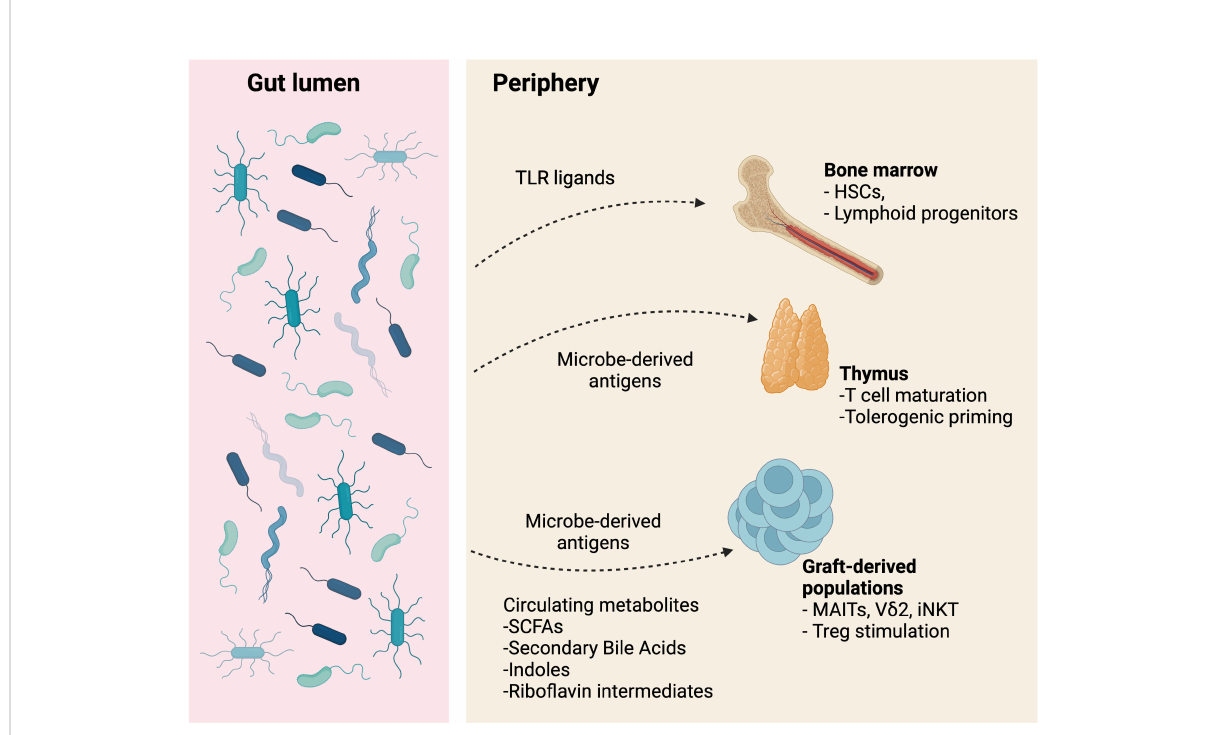
FIGURE 1 The relationships between intestinal bacteria, bacterial ligands, and bacterial metabolites in fl uence bone marrow, thymic, and graft-derived immune development and maintenance. Image created with